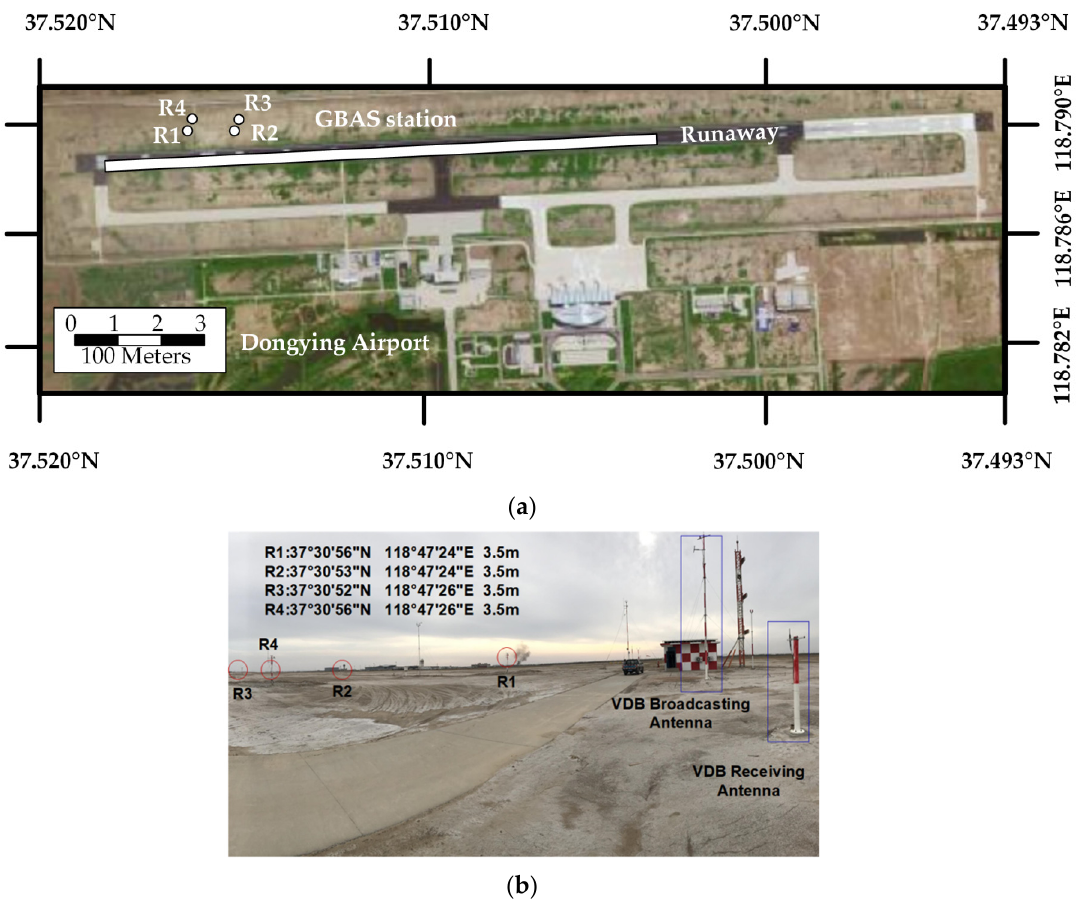
Figure 5. ( a ) Top view of the Dongying Airport environment. ( b ) Locations of the experimental equipment deployed at the airport.